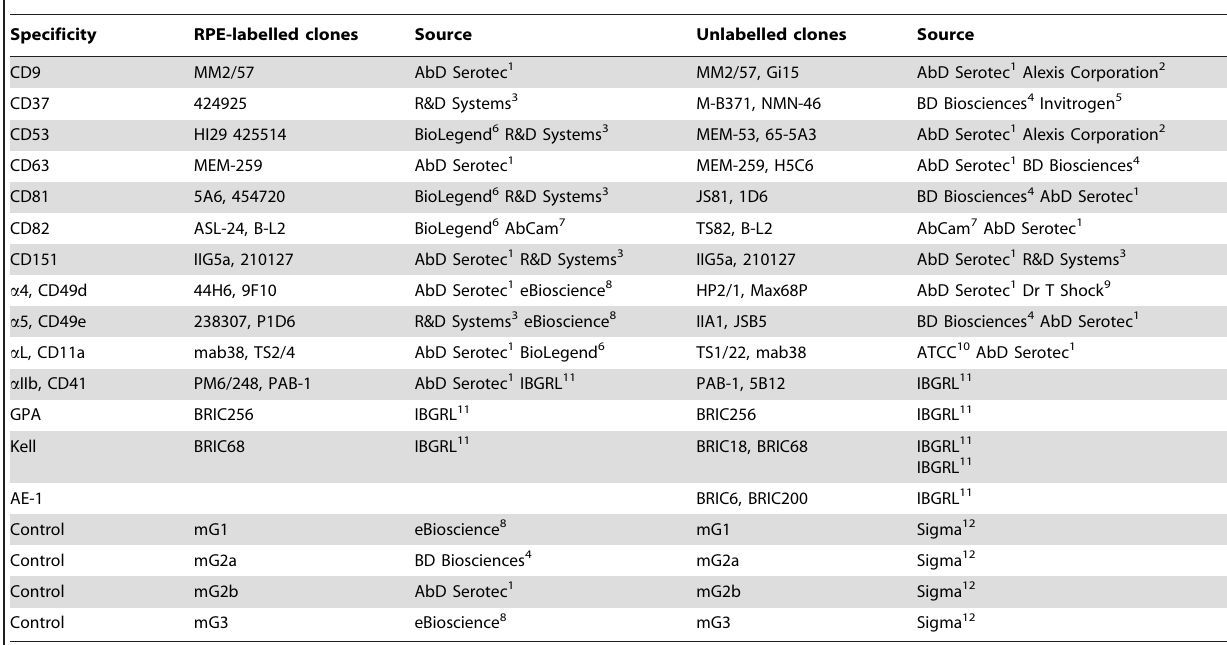
Table 1. Antibodies used for flow cytometry and confocal